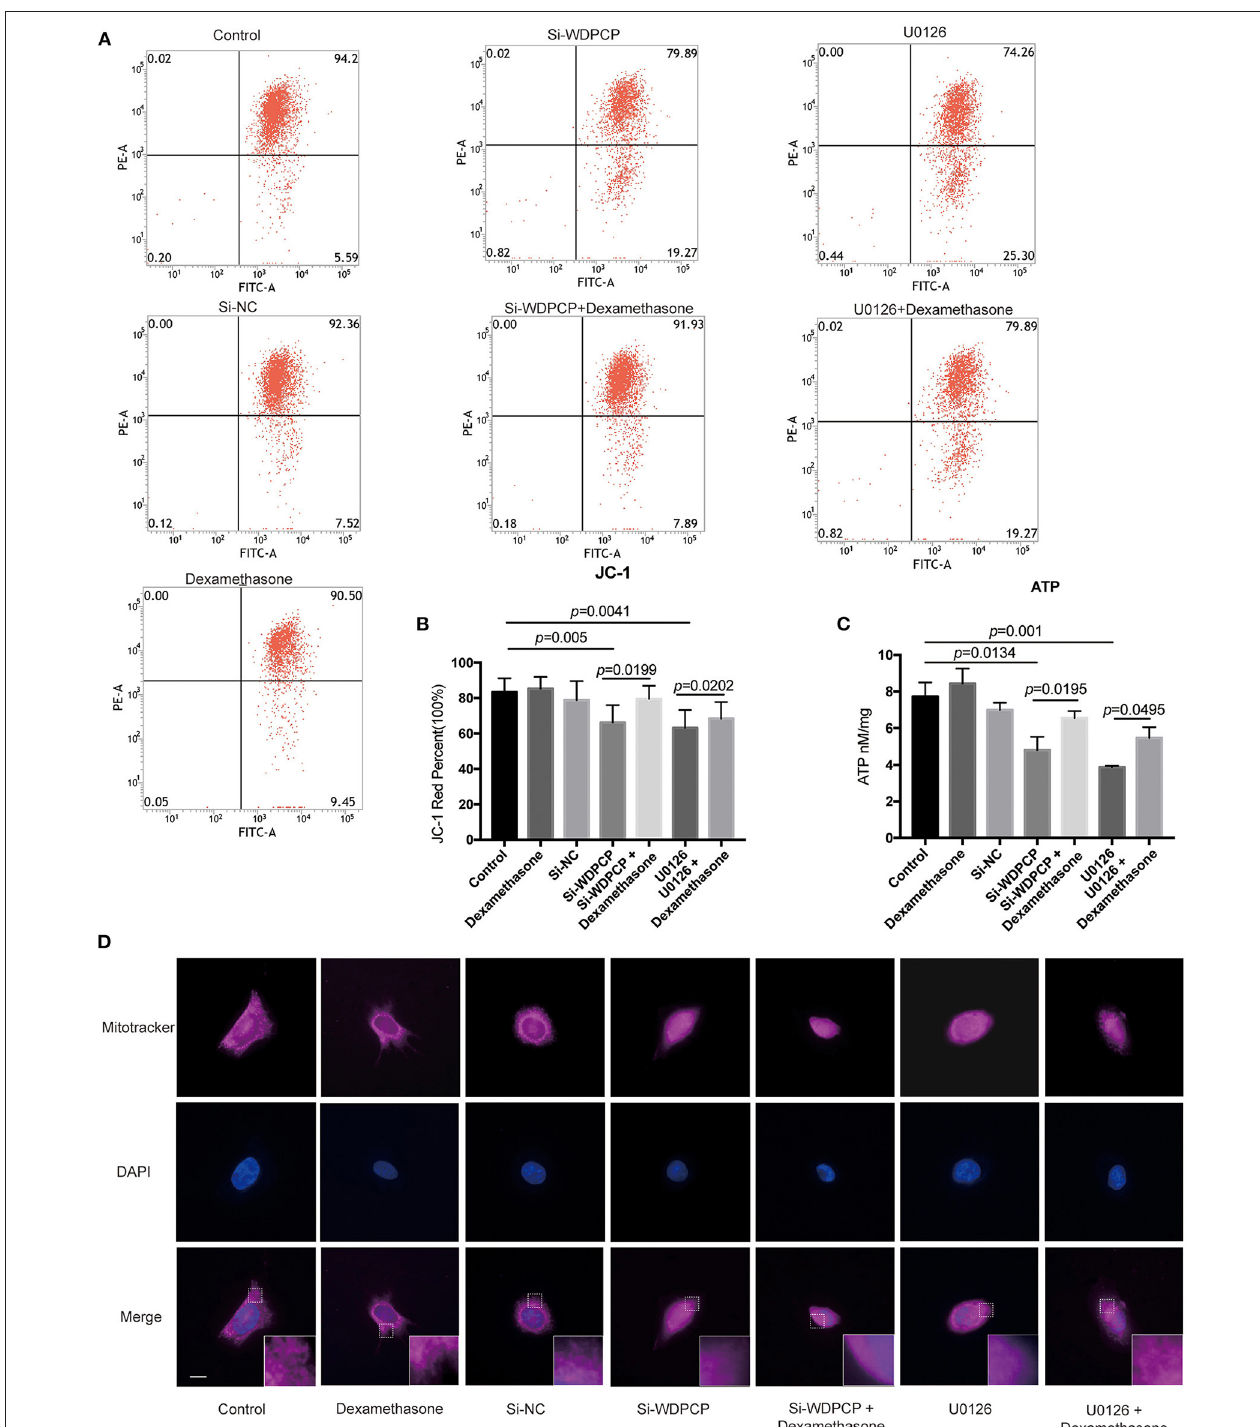
FIGURE 5 | WDPCP impaired mitochondrial function in HSECs by the MAPK/ERK pathway. (A,B) The mitochondrial membrane potential was decreased in Si-WDPCP HSECs and U0126-treated HSECs as observed by JC-1 fluorescent dye analysis, and the mitochondrial membrane potential could be partially restored after adding dexamethasone ( n = 5). (C) ATP levels were decreased in Si-WDPCP HSECs and U0126-treated HSECs; after adding dexamethasone, the ATP levels increased ( n = 5). (D) MitoTracker staining showed that rod-shaped mitochondria were decreased in Si-WDPCP HSECs and U0126-treated HSECs, and the mitochondrial morphology cannot be restored by dexamethasone. Scale bar: 8 µ